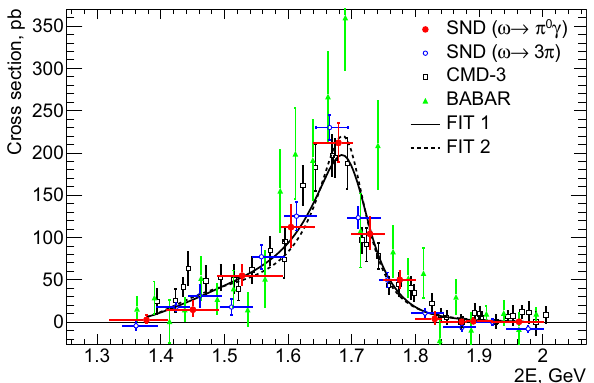
Fig. 4 The energy dependence of the e + e − → ωη → ηπ 0 γ Born cross section measured in this work (filled circles). For comparison, the SND [8] (open circles), CMD-3 [7] (squares), and BABAR [6] (triangles) measurements of the e + e − → ωη cross section in the decay mode ω → π + π − π 0 are shown. These data are multiplied by the branching fraction B (ω → π 0 γ) [27]. The curves show the results of the fit described in the text